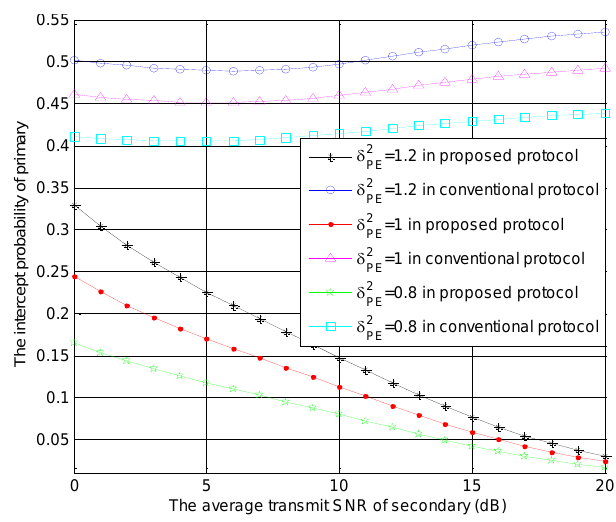
Figure 6. The intercept probabilities of primary users versus r 2 with different σ 2